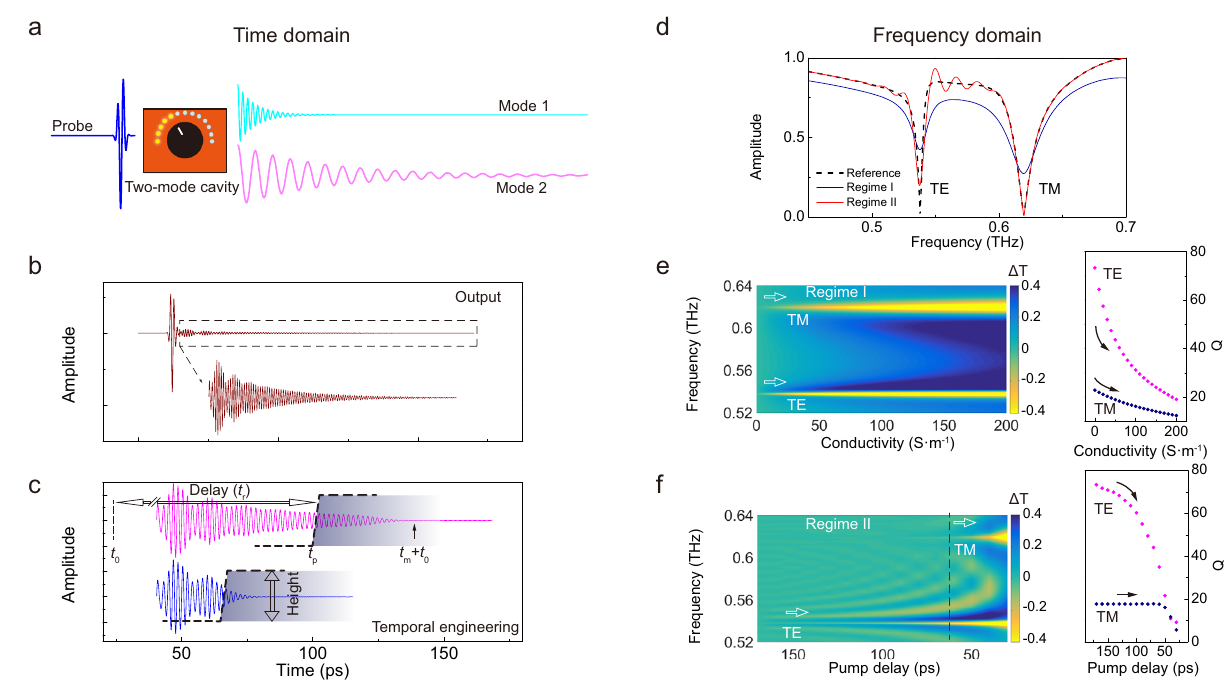
Fig. 1 Concept of temporal loss boundary interpreted from time and frequency domains. a A two-mode cavity interpreted in time domain whose optical properties can be continuously tuned by the knob. b The resultant temporal pro fi le radiated from the two-mode cavity. c The idea to tune cavity properties by introducing a temporal loss boundary that acts as a “ brake ” to hasten the damping rate of oscillation at a selected instant. The two pulses indicate the same truncated oscillations engineered by loss boundary at different instants. Two parameters are de fi ned for the temporal boundary: delay and height. Delay refers to relative time t r between the onset of the detected oscillations ( t 0 ) and pump-on instant ( t p ) of the boundary, and height indicates the strength that determines the rate of “ brake. ” d Modulation of the two-mode cavity interpreted in frequency domain. Dashed line shows the two modes (TE and TM) of the steady cavity; blue line shows the synchronized modulation of both modes in regime I ( t r ≤ 0); and red line shows the asynchronized modulation spectrum in regime II ( t r > 0). e , f Height- and delay-resolved spectra by tuning the boundary strength (characterized by conductivity of cavity material) and delay (characterized by time t r ), and the r esultant evolution of Q factors.